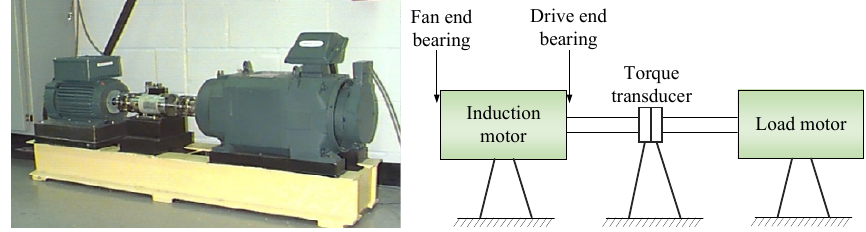
Figure 5. The rolling bearing fault data acquisition experimental bench.